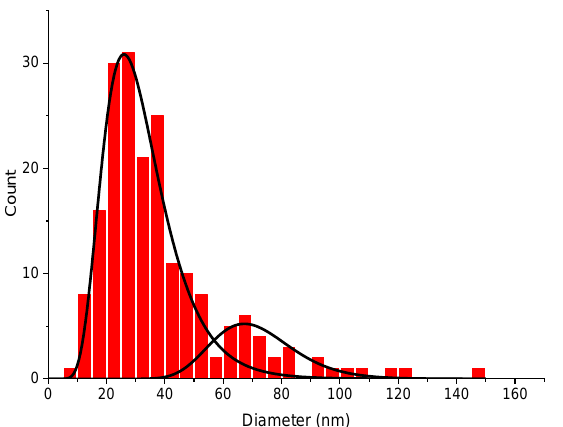
Figure 7. Bimodal number-weighted size distribution of spherical Sm oxide NPs fraction obtained by laser ablation. “Primary” NPs are centered around 25 nm, while “secondary” around 65 nm.